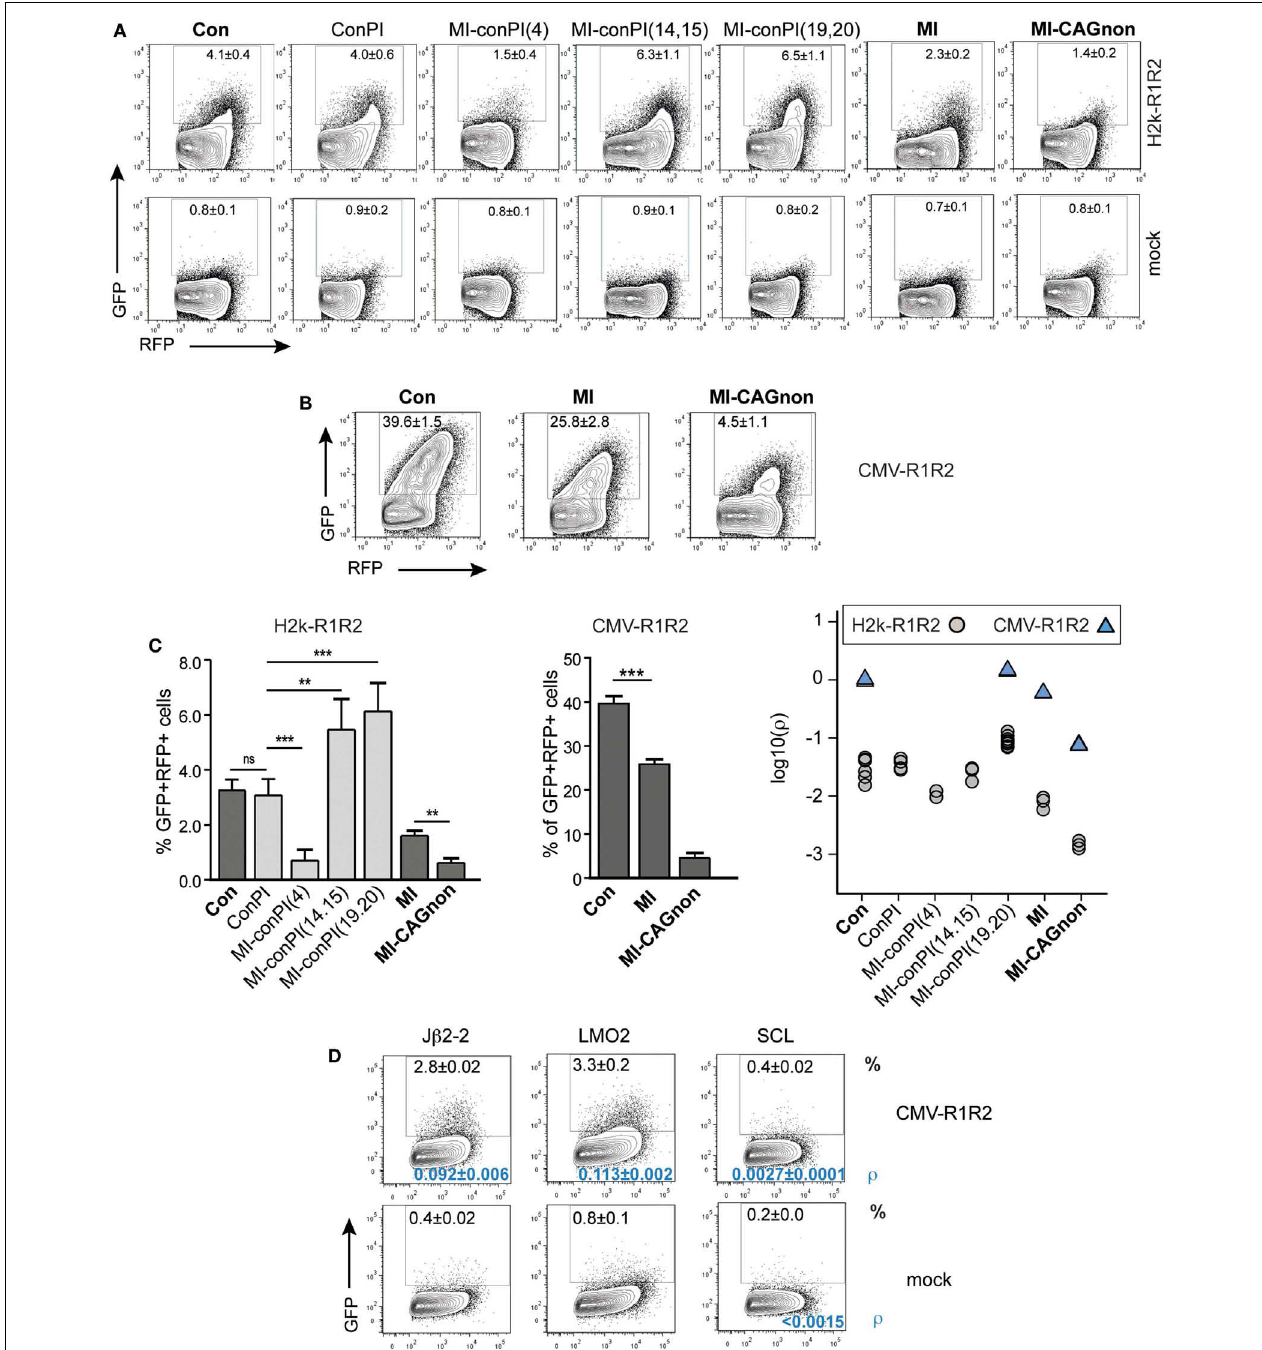
shows the relative recombination coefficient ρ normalized to GFPi-Con. For MI-CAGnon, the less efficient RSS, ρ in the mock was < 5.10 − 5 D ) FACS analysis of 293T cells transfected with CMV-RAG1/2 and GFPi variants carrying 12-RSS of poor efficiencies paired with Con23. J β 2-2 is found at the TCR β locus, LMO2 and SCL are putative cRSS. Mock is J β 2-2 transfected alone.The frequency of GFP + RFP + cells in an RFP + gate is indicated in the upper part of the plot and the recombination coefficient ρ relative to GFPi-Con in A, for which ρ = 1.0 ± 0.2) in the bottom part, in blue. Standard deviation of three replicates and their significance vs. the mocks. (** p < 0.05, *** p < 0.001, ns – not